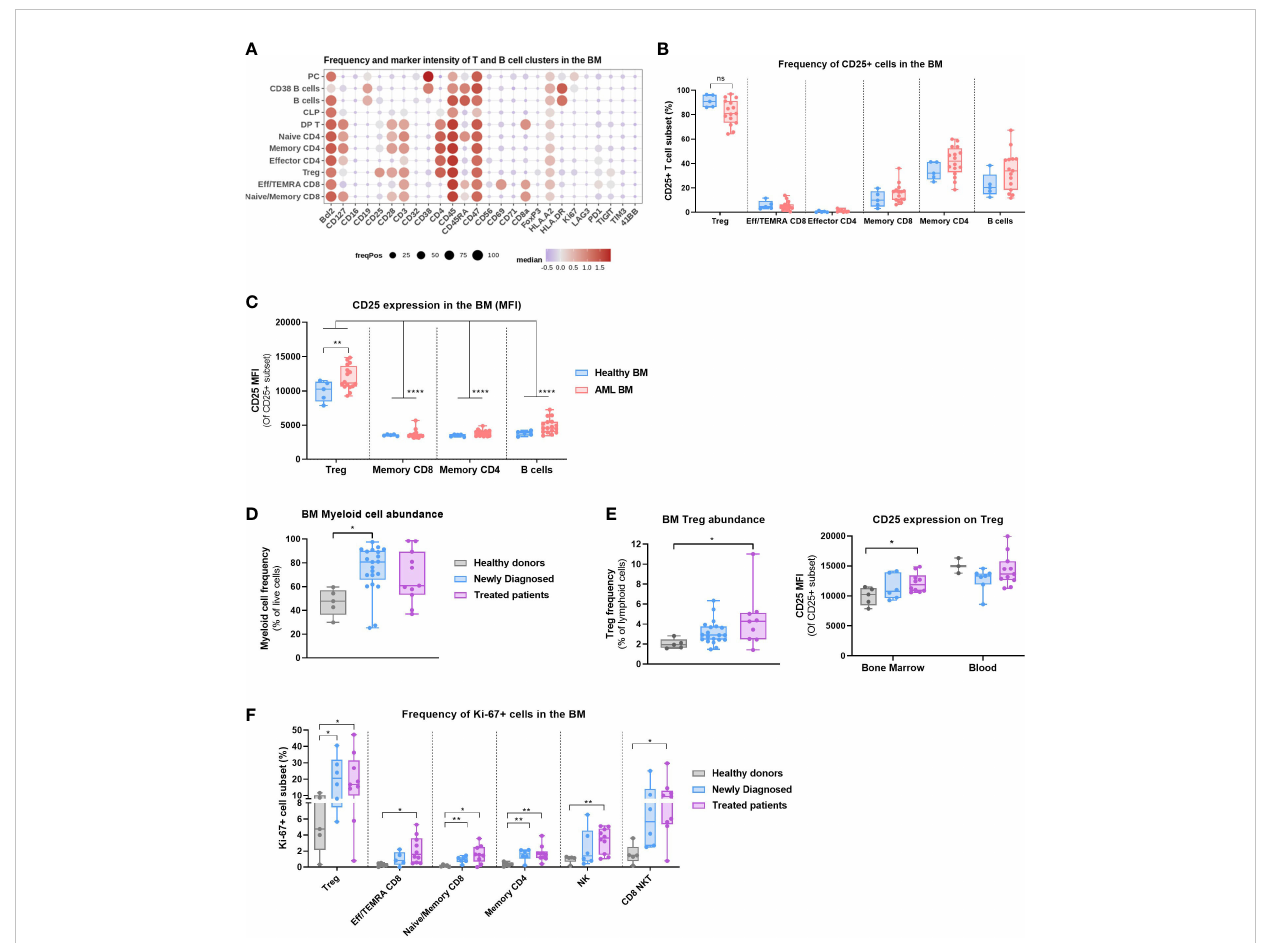
FIGURE 2 Regulatory T cells are present in the bone marrow of AML patients and express CD25. (A – C) Data obtained with BM samples in Study #2. (A) Dot plot depicting the expression of 26 markers on annotated T and B cell clusters. Color code indicates the median expression (logicle transformed MFI); point size indicates the fraction of cells positive for each marker. (B) Frequency of CD25+ mature T and B cell subsets. Two-way ANOVA, Sidak ’ s multiple comparison test. (C) CD25 expression (MFI) on selected T and B cell subsets. Two-way ANOVA, Sidak ’ s multiple comparison test (for the comparison of Healthy vs AML) or Tukey ’ s multiple comparison test (for the comparison of expression between cell subsets). (D) Myeloid cell abundance in the bone marrow of HD (n=5), Newly Diagnosed (n=22) and Treated patients (n=11). Data compiled from Study #1 and #2. Kruskal- Wallis with Dunn ’ s multiple comparison test. (E) Left: Treg abundance in the bone marrow of HD, Newly Diagnosed and Treated patients. Data compiled from Study #1 and #2. Kruskal-Wallis with Dunn ’ s multiple comparison test. Right: CD25 expression on Treg in the blood vs bone marrow of HD, Newly Diagnosed and Treated patients in Study #2. Multiple t tests, Holm-Sidak correction for multiple comparisons. (F) Frequency of Ki67+ cell populations between HD (n=5), Newly Diagnosed (n=7) and Treated patients (n=10) in Study #2. Multiple t tests, not corrected for multiple comparisons. Signi fi cance levels are de fi ned in the methods section. P values > 0.05 are not indicated on the graphs. BM, Bone marrow; HD, Healthy donor; Treg, Regulatory T cell; NK, Natural Killer cell. Signi fi cance levels are indicated as follows: ns or not indicated, not signi fi cant, P > 0.05; *P